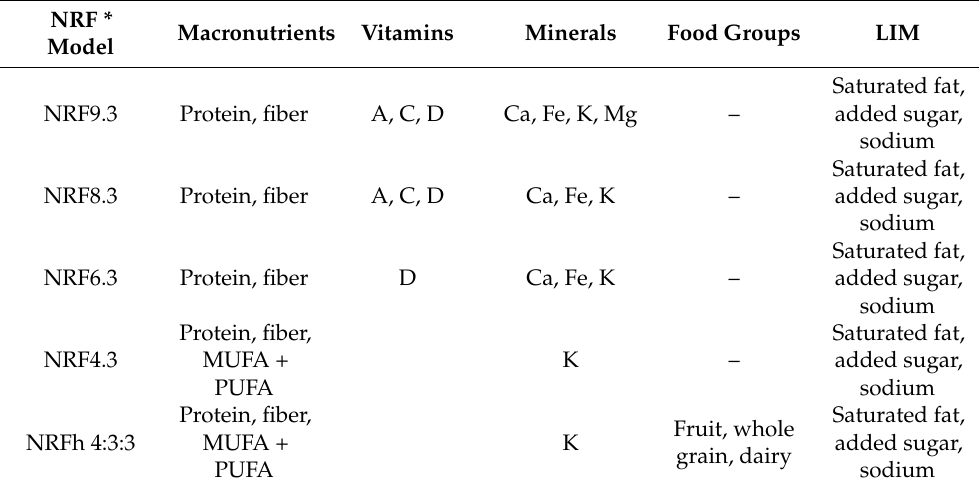
Table 2. Nutrients, micronutrients, and food groups used in nutrient profiling (NP)